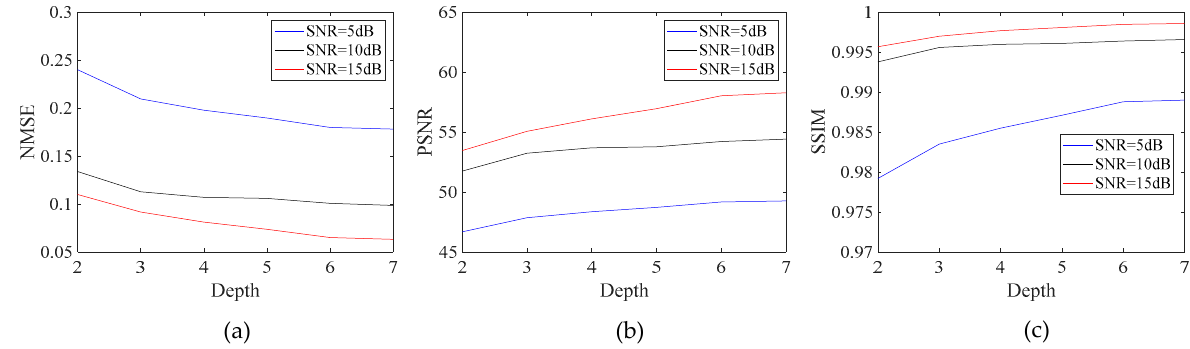
Table 13. Parameters of different depth.